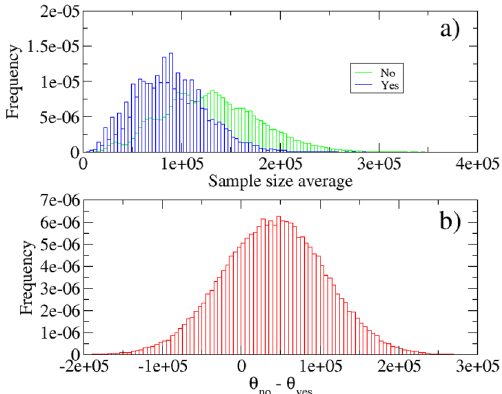
Figure 4. Results of the bootstrapping inference. ( a ) Bootstrap distributions of the number of events contained in the data-sets considered in the studies that has rejected the hypothesis of magnitude correlation (no) and accepted the hypothesis (yes). The mean was chosen as statistics. ( b ) The distribution of the difference θ no − θ yes .